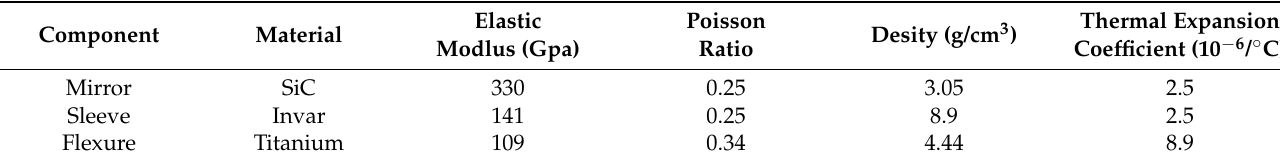
Table 1. Material properties of the space mirror assembly.